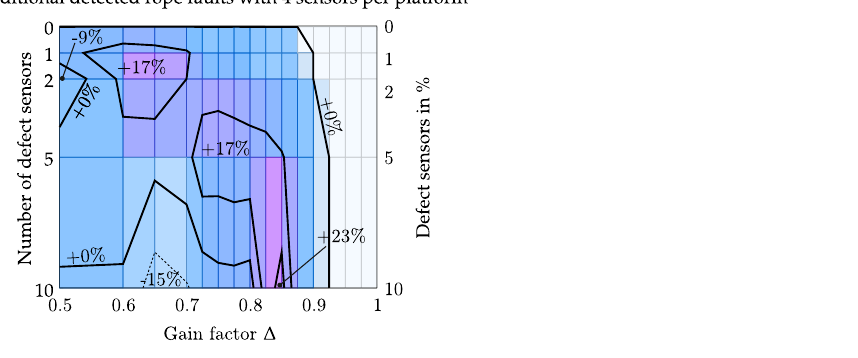
Figure 12. Improvement of fault detection using 4z acceleration sensors with sensor gain defects.